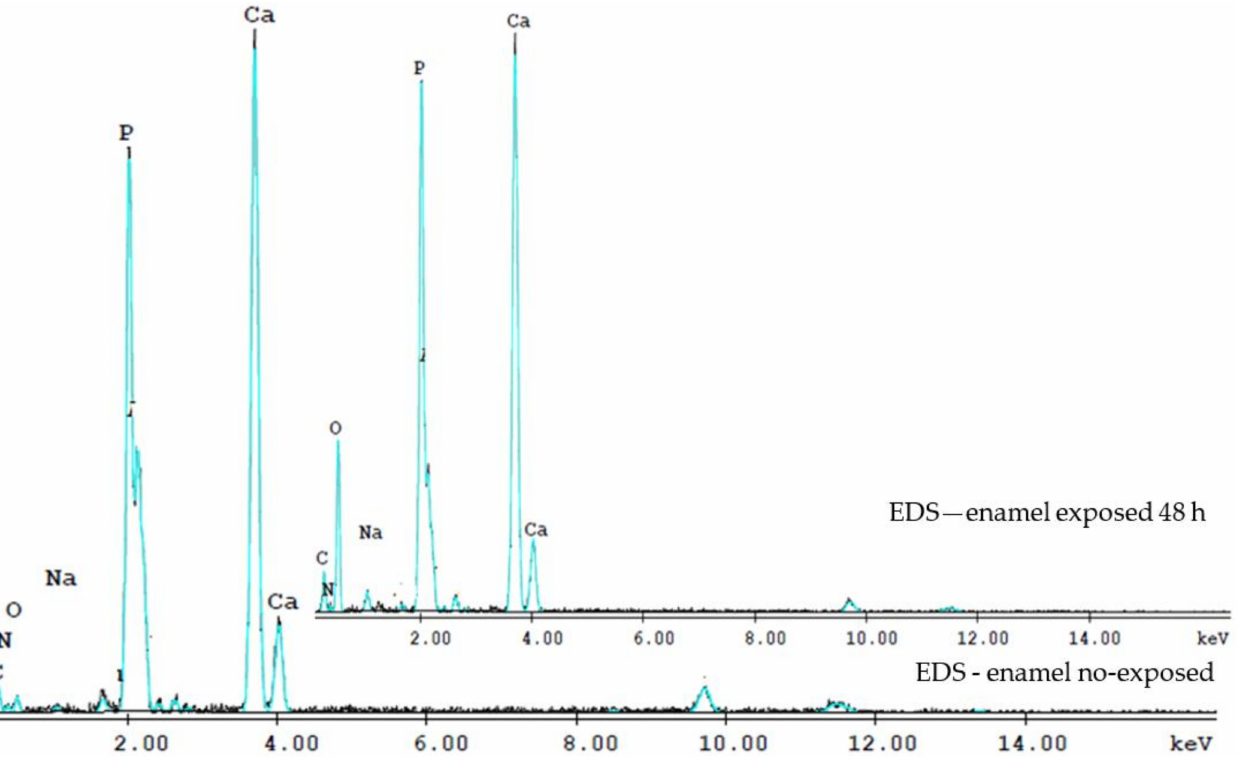
Figure 3. The EDS spectra evidence the Ca and P contents of the enamel no-exposed and exposed 48 h to the laser irradiation. The Ca/P ratio at 48 h was lower than that of no-exposed